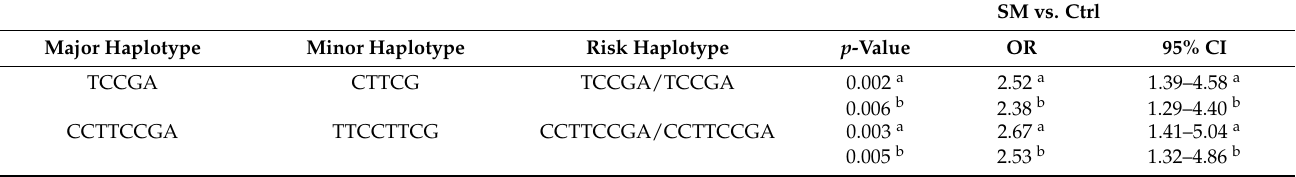
Table 3. Haplotype association analysis for the five and eight SNPs in the Senegalese population.